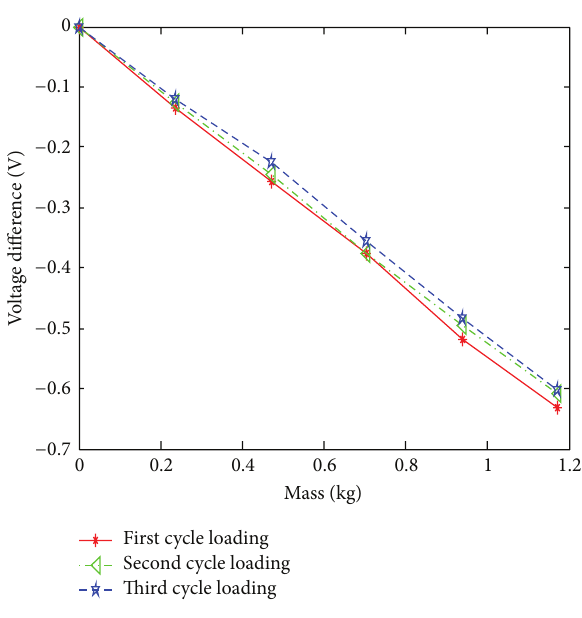
Figure 7: Three cycles